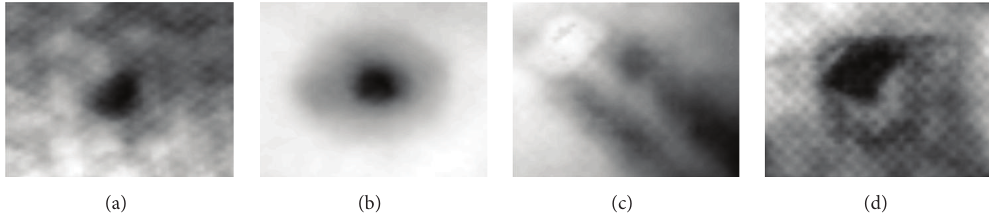
Figure 18: Results of the PCA-DWT data fusion algorithm obtained for sample: (a) 𝑠 IMP 2 J , (b) 𝑠 IMP 5 J , (c) 𝑠 INC A , and (d) 𝑠 INC B .